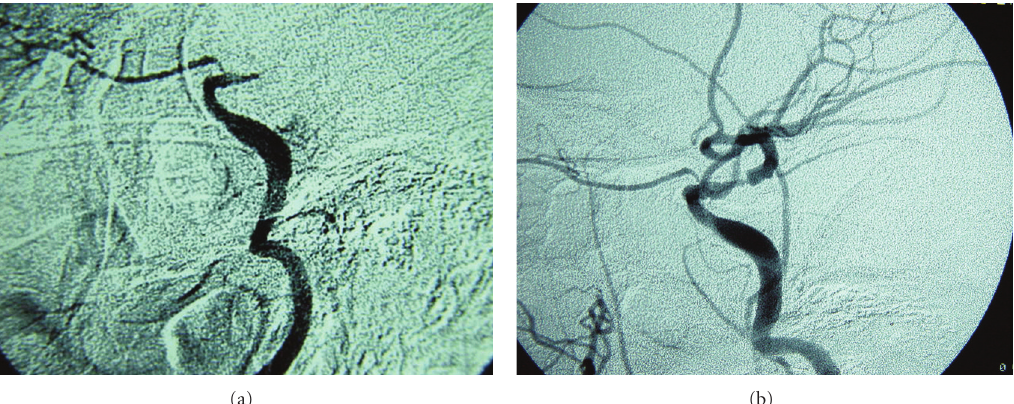
Figure 2: (a) Slow injection of dilute urokinase with microcatheter at site of occlusion; (b) recanalization of the right MCA with residual carotid